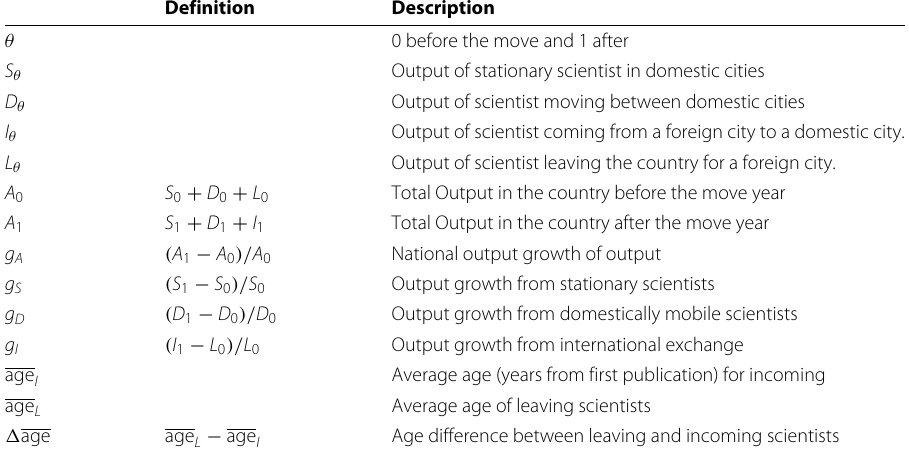
Table 1 Country level Brain Circulation